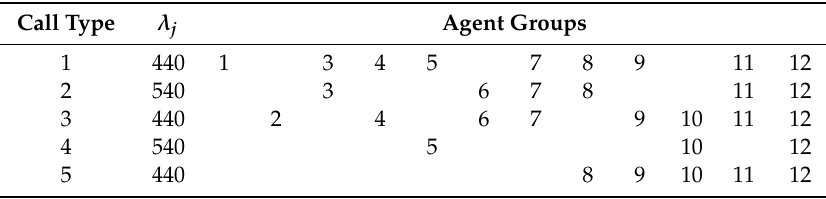
Table 1. Skill groups of the small